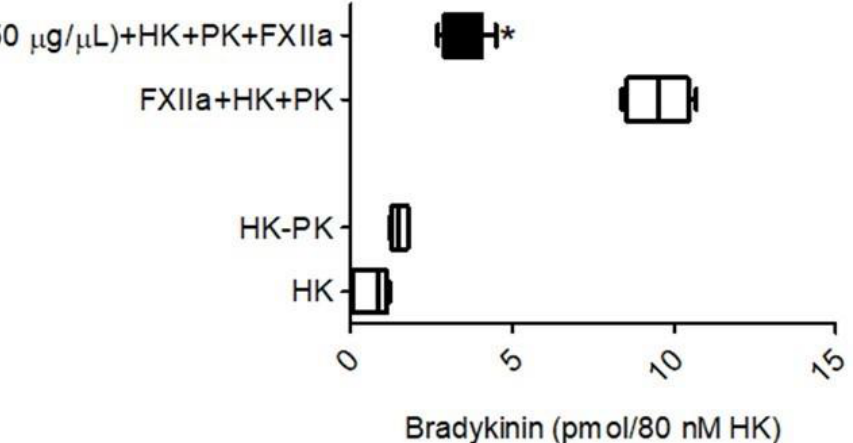
Figure 8. Showing the effect of tea water extract on BK production. Hydrolysis of high-molecular-weight kininogen (HK, 80 nM) was studied by following the changes in the amounts of product, BK in the absence or presence of the activated factor XII (FXIIa) and prekallikrein (PK, 80 nM). Each bar represents nine runs. Statistical significance was measured with the two-way ANOVA. * p < 0.05 compared to FXIIa + HK + PK.